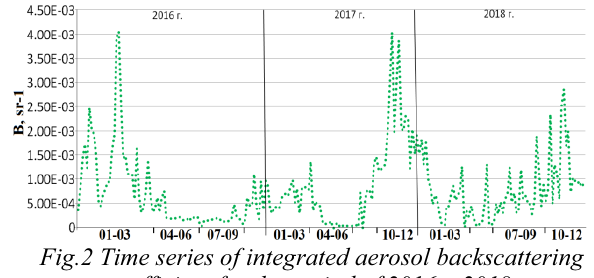
Fig. 3. Lidar and satellite observations of manifestation of stratospheric warming in January 2016. Temperature profiles, calculated from lidar measurements of Rayleigh and Raman signals (red and yellow lines) and their standard deviations (black lines), observations from Aura satellite and meteorological sondes (blue and light blue lines), and monthly average profile according to CIRA-86 model (green